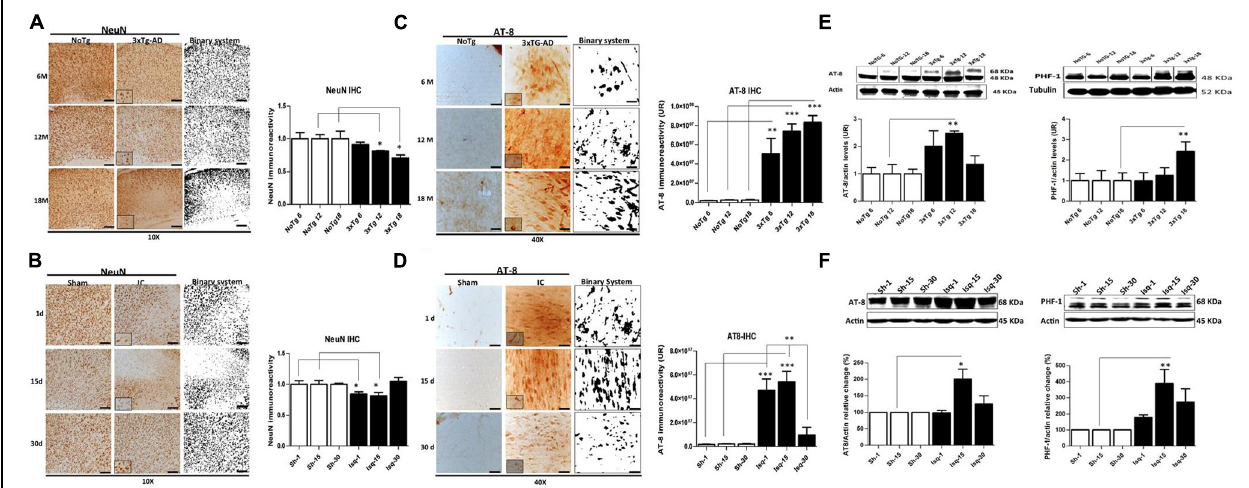
FIGURE 1 | Temporal course of the neuronal population and hyperphosphorylated tau in 3xTg-AD mice and 2VO cerebral ischemia in rats. (A) NeuN immunoreactivity (IR) decreased at 6 ( p ≤ 0.0212), 12 ( p ≤ 0.0213), and 18 months ( p ≤ 0.0422) in the SS-Cx of the 3xTgAD mouse model. (B) NeuN IR decreased at 1 ( p ≤ 0.0403) and 15 days ( p ≤ 0.0417) post-ischemia, while increased at 30 days post-ischemia ( p ≤ 0.2616). Both models were compared with the internal control groups, NoTg and sham animals respectively n = 3 animals/group. Scale bar, 150 μ m; magnification 10X (insert 100X) . (C) AT-8 IR increased at 12 months ( p ≤ 0.0001) and 18 months ( p ≤ 0.0001) in the SS-Cx of the 3xTgAD mice compared with the 3xTg-AD